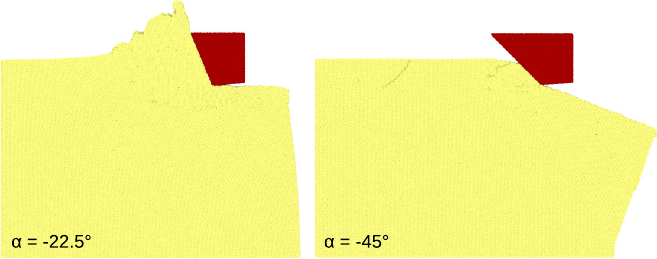
Figure A4. Side views of the chips formed during cutting for an extended simulation up to 200 Å for the negative rake angles, α = − 22.5 ◦ and − 45 ◦ .